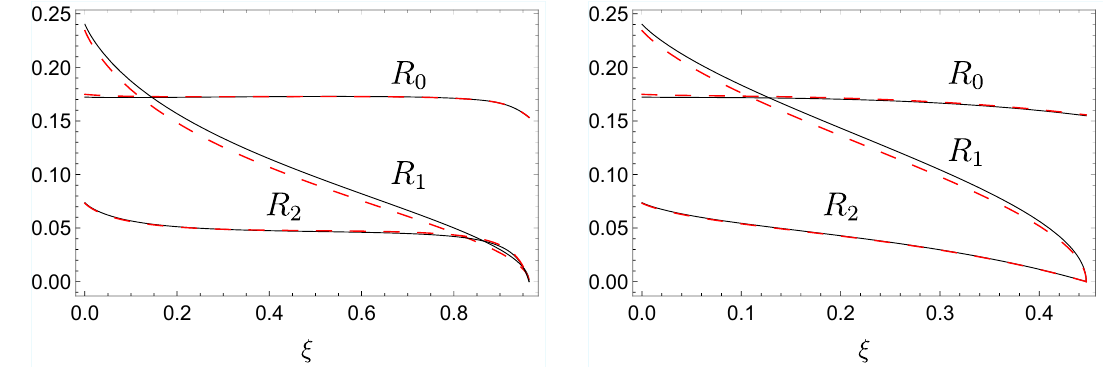
Figure 1 . The ratios R k (4.6) of the imaginary parts of the helicity amplitudes taking into account leading kinematic power corrections (black solid curves) and the complete results (3.55) to 1 / ( qq 0 ) 2 accuracy (red dashed curves) as functions of the skewedness parameter for Q 2 = 5 GeV 2 and t = − 1 GeV 2 . The left panel: m = 0 . 14 GeV; the right panel: m = 1 GeV. results are presented on the left and the right panel in figure 1, respectively. The leading power contributions to the ratios R ( ξ ) are shown by solid black curves and the complete k results to the 1 / ( qq 0 ) 2 accuracy by red